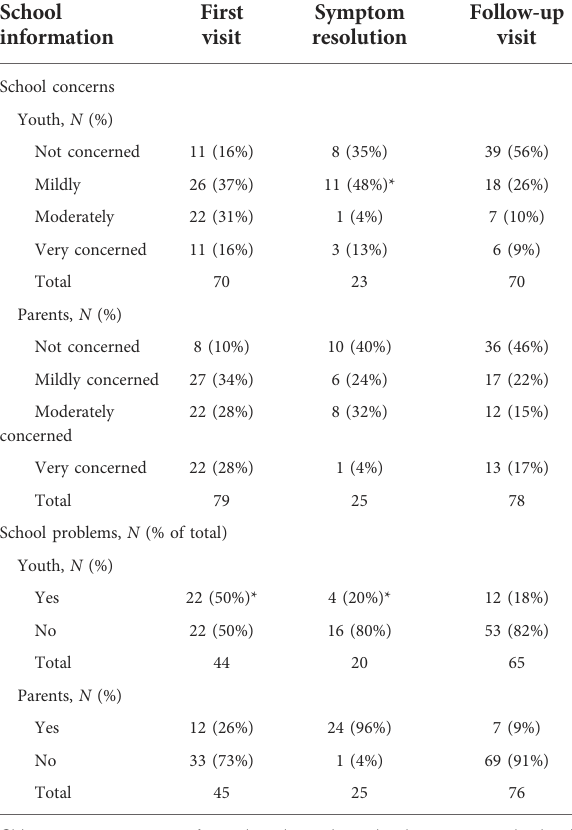
TABLE 6 Comparison of youth and parent report of school problems and